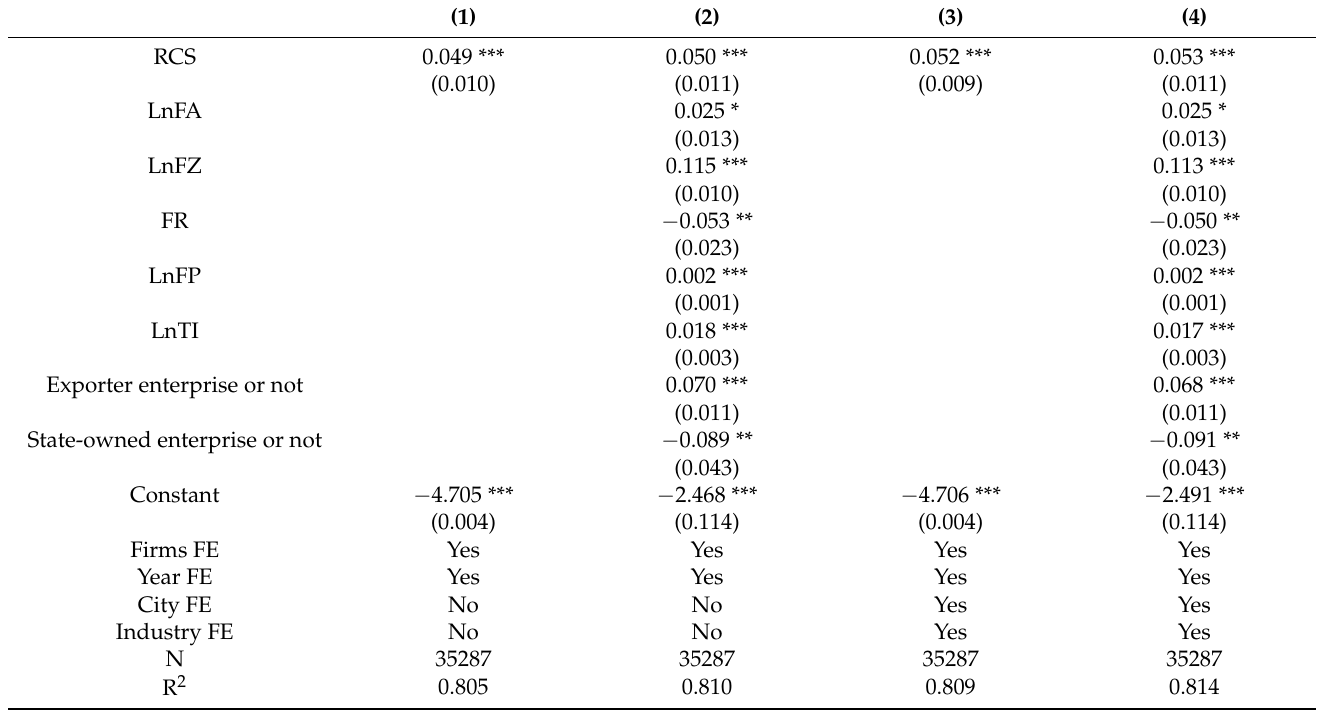
Table 4. The benchmark regression